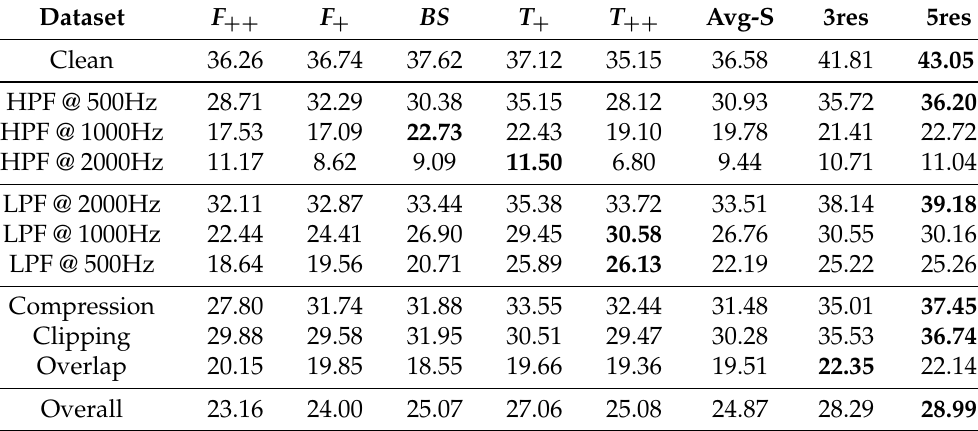
Table 5. Macro-averaged, event-based F 1 scores of single-resolution and multiresolution systems over DESED Public evaluation set (“Clean”) and proposed degradation scenarios. “Avg-S” col- umn presents average performance of single-resolution systems ( F ++ , F + , BS , T + , T ++ ). “Overall” row presents averaged results across all degradation scenarios. Best result for each row is high- lighted in